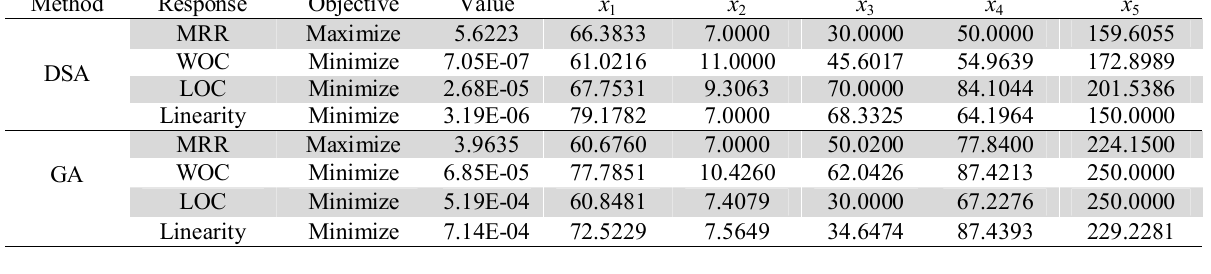
Genetic Algorithm (GA) Differential Search Algorithm (DSA)